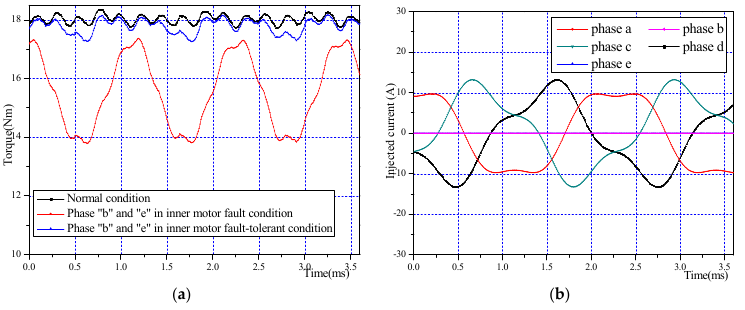
Figure 21. The motor operates under non ‐ adjacent double ‐ phase open circuit in inner motor condition: ( a ) electromagnetic torque obtained by FEA; ( b ) the injected currents of inner motor. 3.2.3. Adjacent Double ‐ Phase Open ‐ Circuit in Outer Motor while Inner Motor Operates Normally